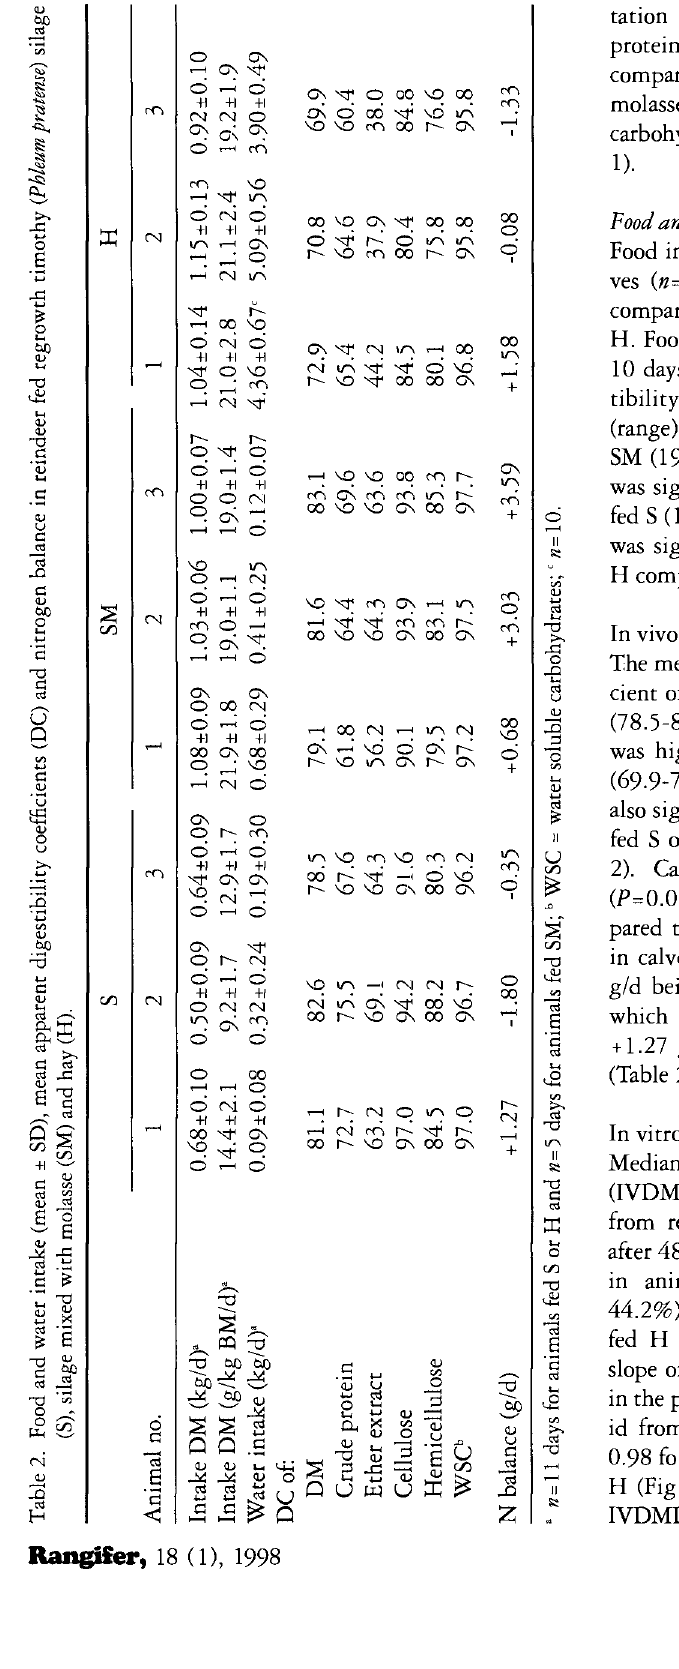
slope of the regression line through all the data in the plot for IVDMD of cellulose in rumen flu id from reindeer fed S was 0.83, compared to 0.98 for reindeer fed SM and 1.2 for reindeer fed H (Fig. 1). The slope of the regression line for IVDMD of cellulose in rumen fluid from